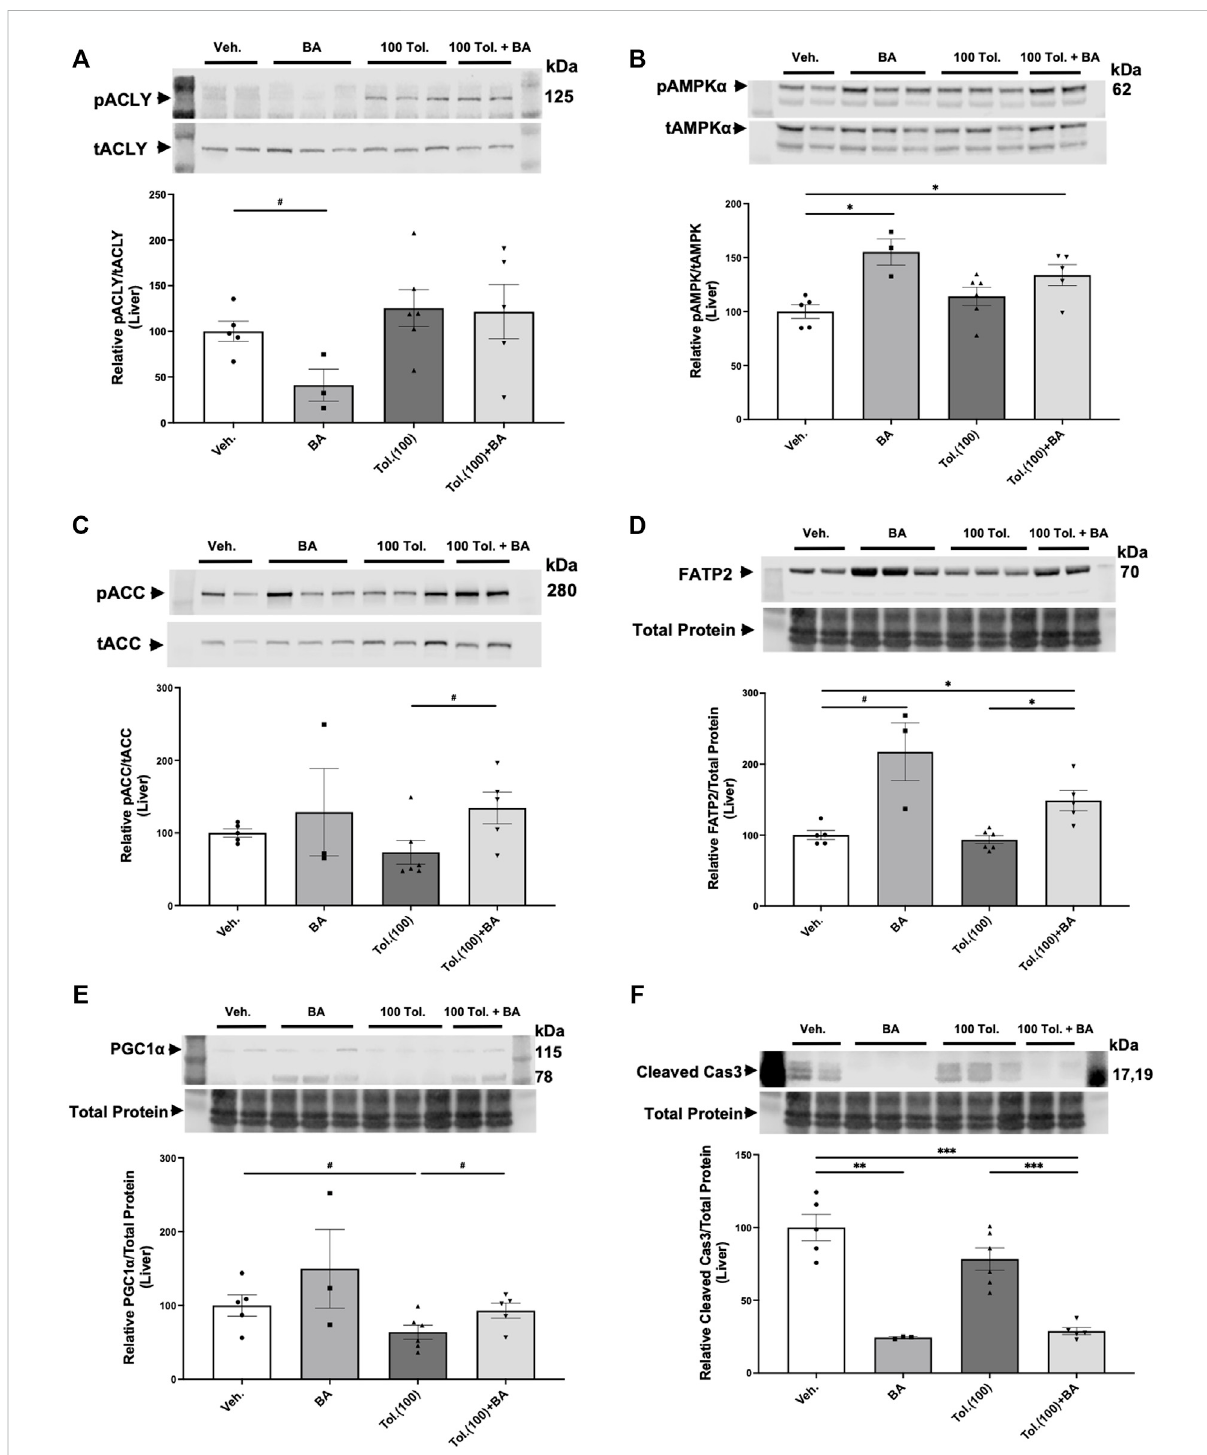
Effects of bempedoic acid (BA) and tolvaptan treatment in PKD mice on protein expression of key signaling markers in liver homogenates. Immunoblots were performed on liver tissue homogenates from Pkd1 fl / fl ; Pax8-rtTA; Tet-O-Cre mice with early/rapid induced Pkd1 gene inactivation with or without concurrent treatment with BA (30 mg/kg/d) and/or tolvaptan (100 mg/kg/d). Densitometric intensities of immunoblot bandsfromeachlanewerenormalizedtothetotalproteinsignalfromthatlaneasaloadingcontrol[showninmiddlepanelsof (D) , (E) and (F) ]or normalized to the total non-phosphorylated protein signal [shown in middle panels of (A) , (B) , and (C) ]. Liver homogenates were probed for: (A) phosphorylatedACLY(pSer455ACLY;pACLY)andtotalACLY(tACLY); (B) phosphorylatedAMPK α (pThr172AMPK;pAMPK α )andtotalAMPK α (tAMPK); (C) phosphorylated ACC (pACC) and total ACC; (D) . FATP2 expression; (E) . the mitochondrial biogenesis marker PGC-1 α ; and (F) . the apoptosis marker cleaved caspase 3. Representative immunoblots are shown in upper and middle panels, and summary quantitation of mean (±SE) relative protein expression levels are shown in lower panels ( # 0.05 < p < 0.10, * p < 0.05, ** p < 0.01, *** p < 0.001 or as stated for the indicated